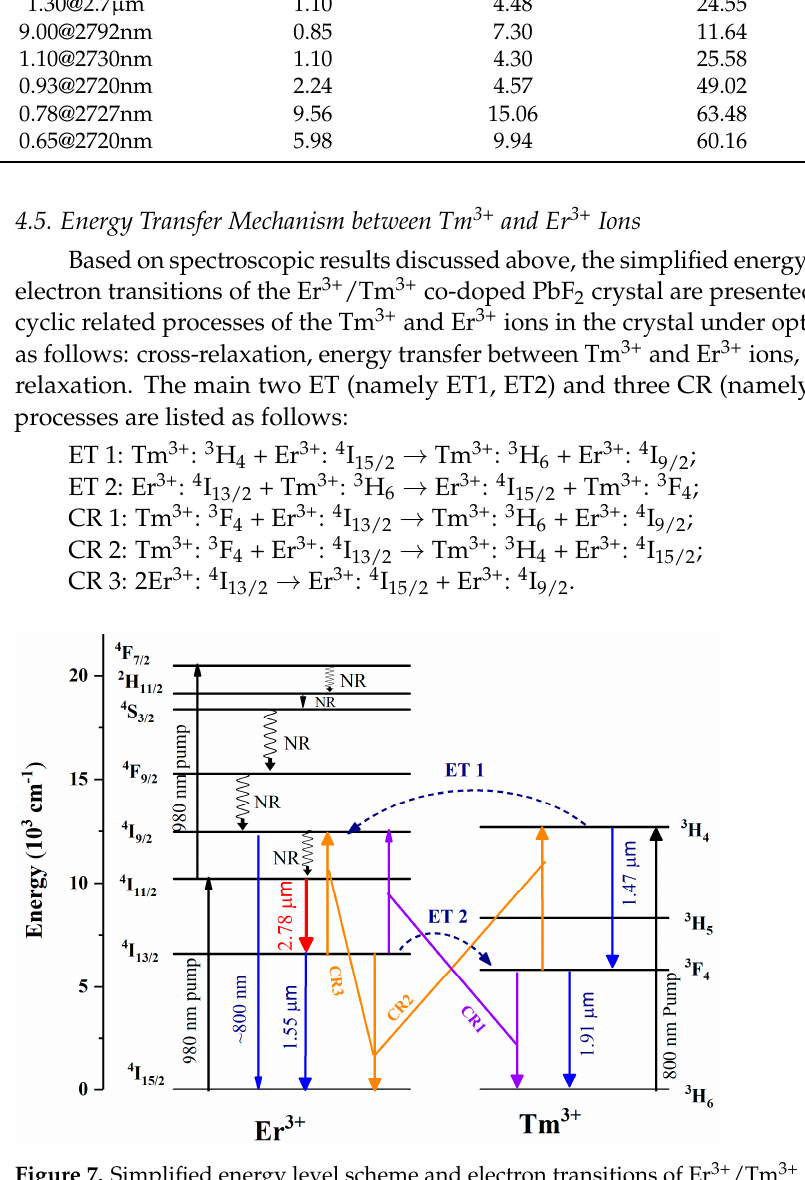
Figure 7. Simplified energy level scheme and electron transitions of Er 3+ /Tm 3+ co-doped